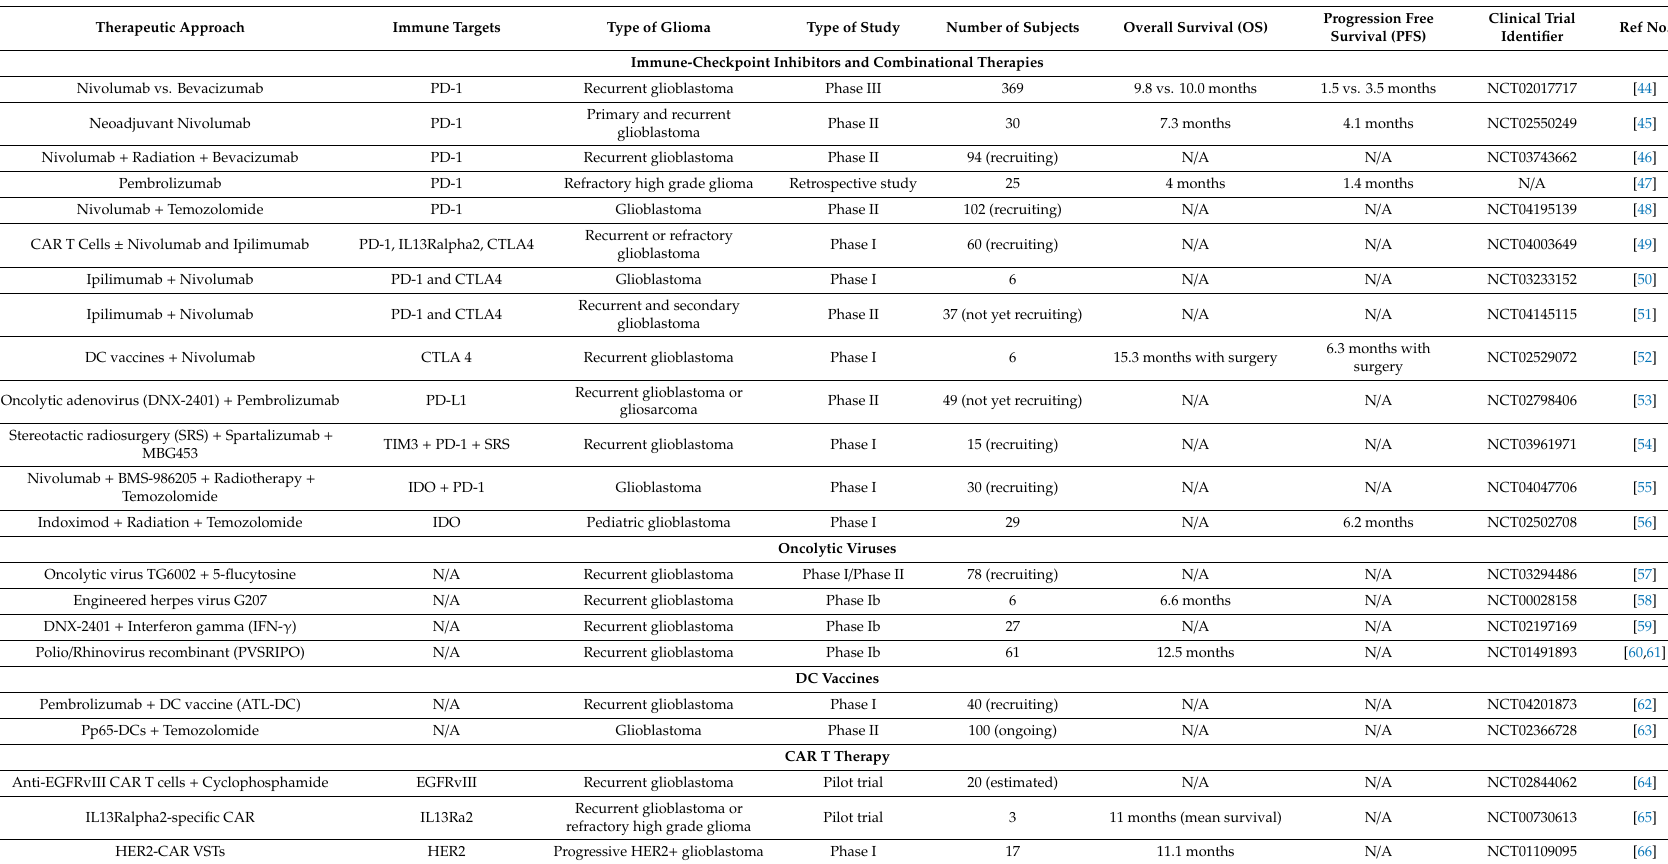
Table 1. Recent clinical studies with immune-checkpoint inhibitors and some combinational therapies targeting glioblastoma. TherapeuticApproach